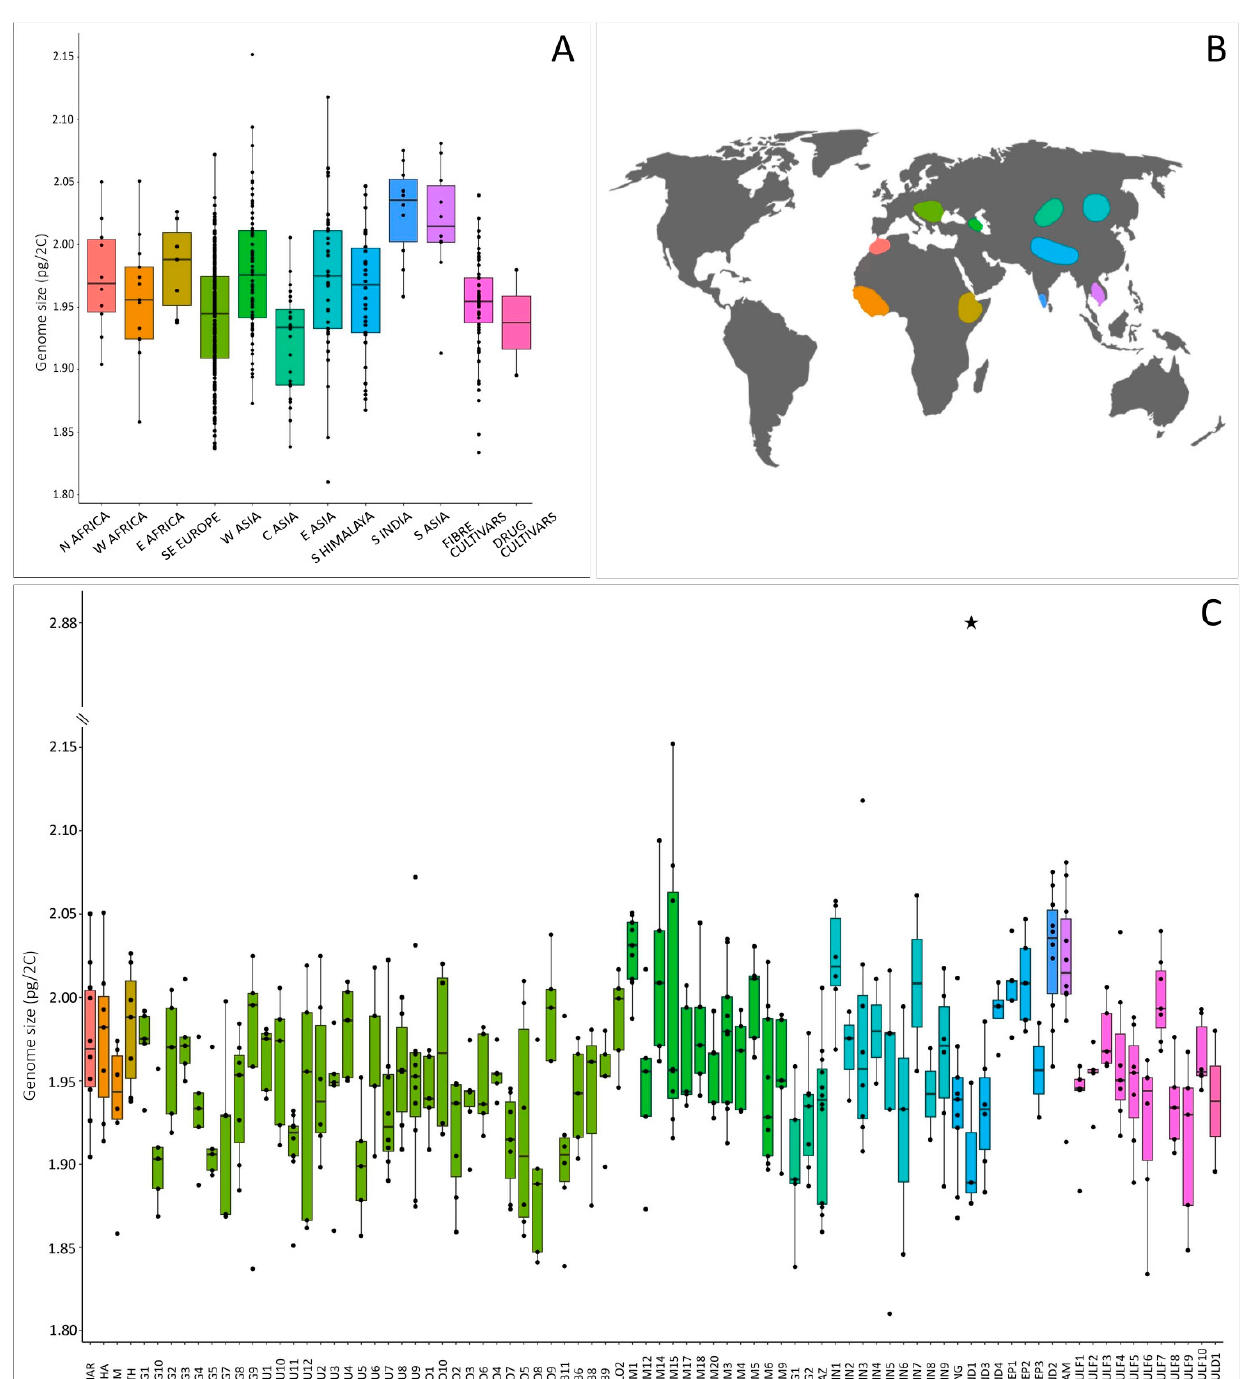
Figure 1. ( A ) Boxplots showing the distribution of genome size in diploid Cannabis individuals in different distribution areas. ( B ) Map of the areas of origin of the sampled accessions. ( C ) Boxplots showing the distribution of genome size in Cannabis individuals per accessions (the star indicates the genome size of the triploid individual found in the accession IND1—North India).